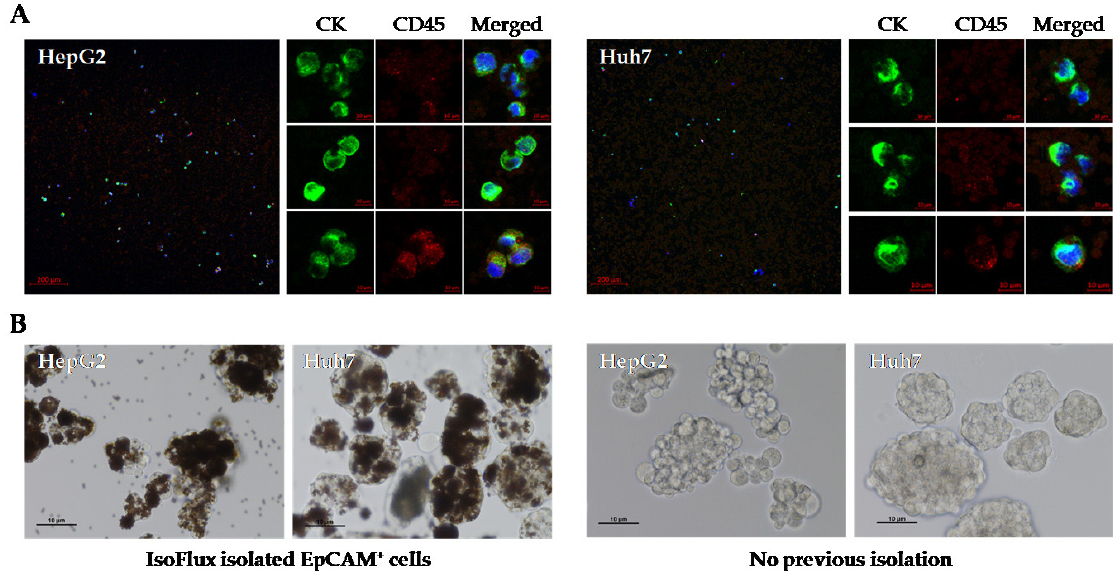
Figure 3. Utility of the IsoFlux system for obtaining cancer stem cell spheroids from established human HCC cell lines. EpCAM + CTCs derived from cell lines HepG2 and HuH7 were isolated by the IsoFlux system and ( A ) visualized by immunofluorescence or ( B ) cultured under ultra-low adherence conditions to favor the growth of spheroids. Spheres from cells that were not previously isolated with magnetic beads are also shown. Growth on day 9 is shown.